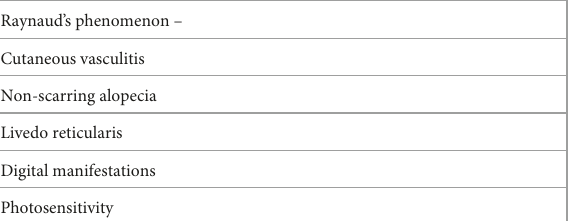
TABLE 2 LE non-specific skin